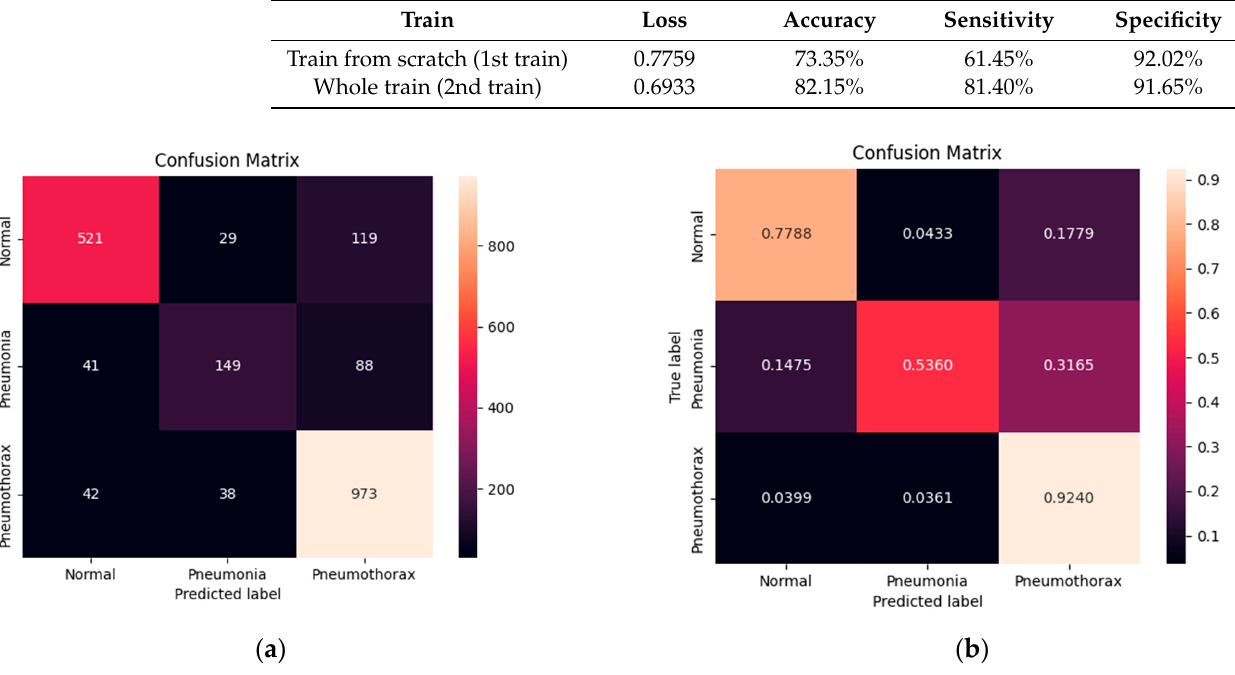
Table 9. Summary of the validation performance of the NIH data set.